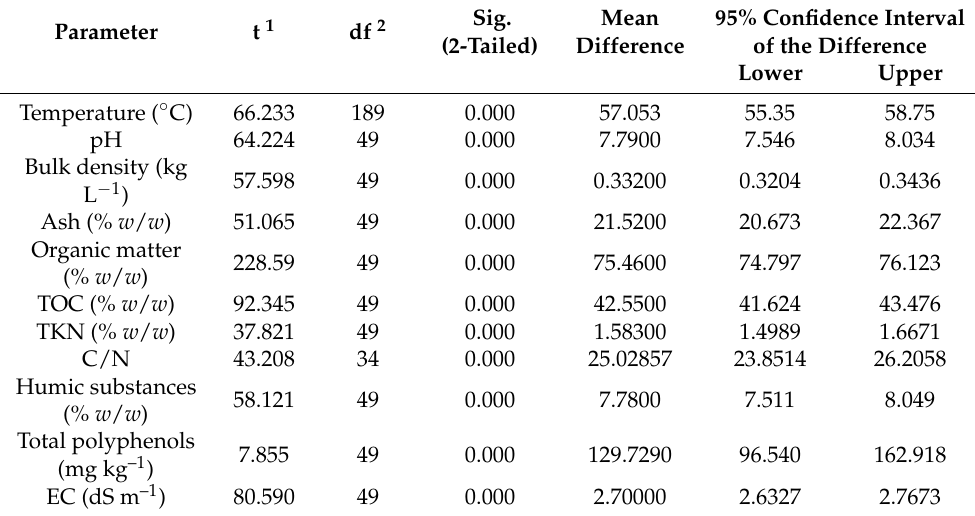
Table 4. Statistical processing of data in Figures